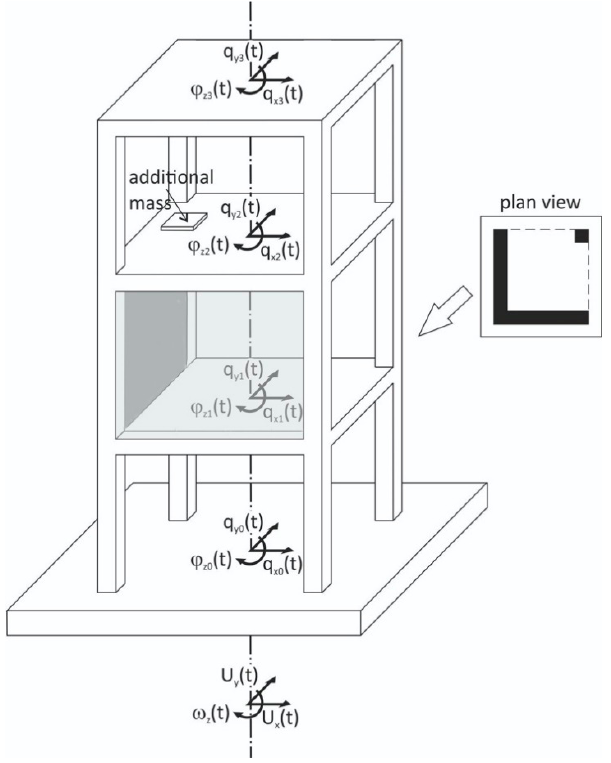
Figure 4. Simplified, three story, axially asymmetric building under horizontal–torsional excita- tions.